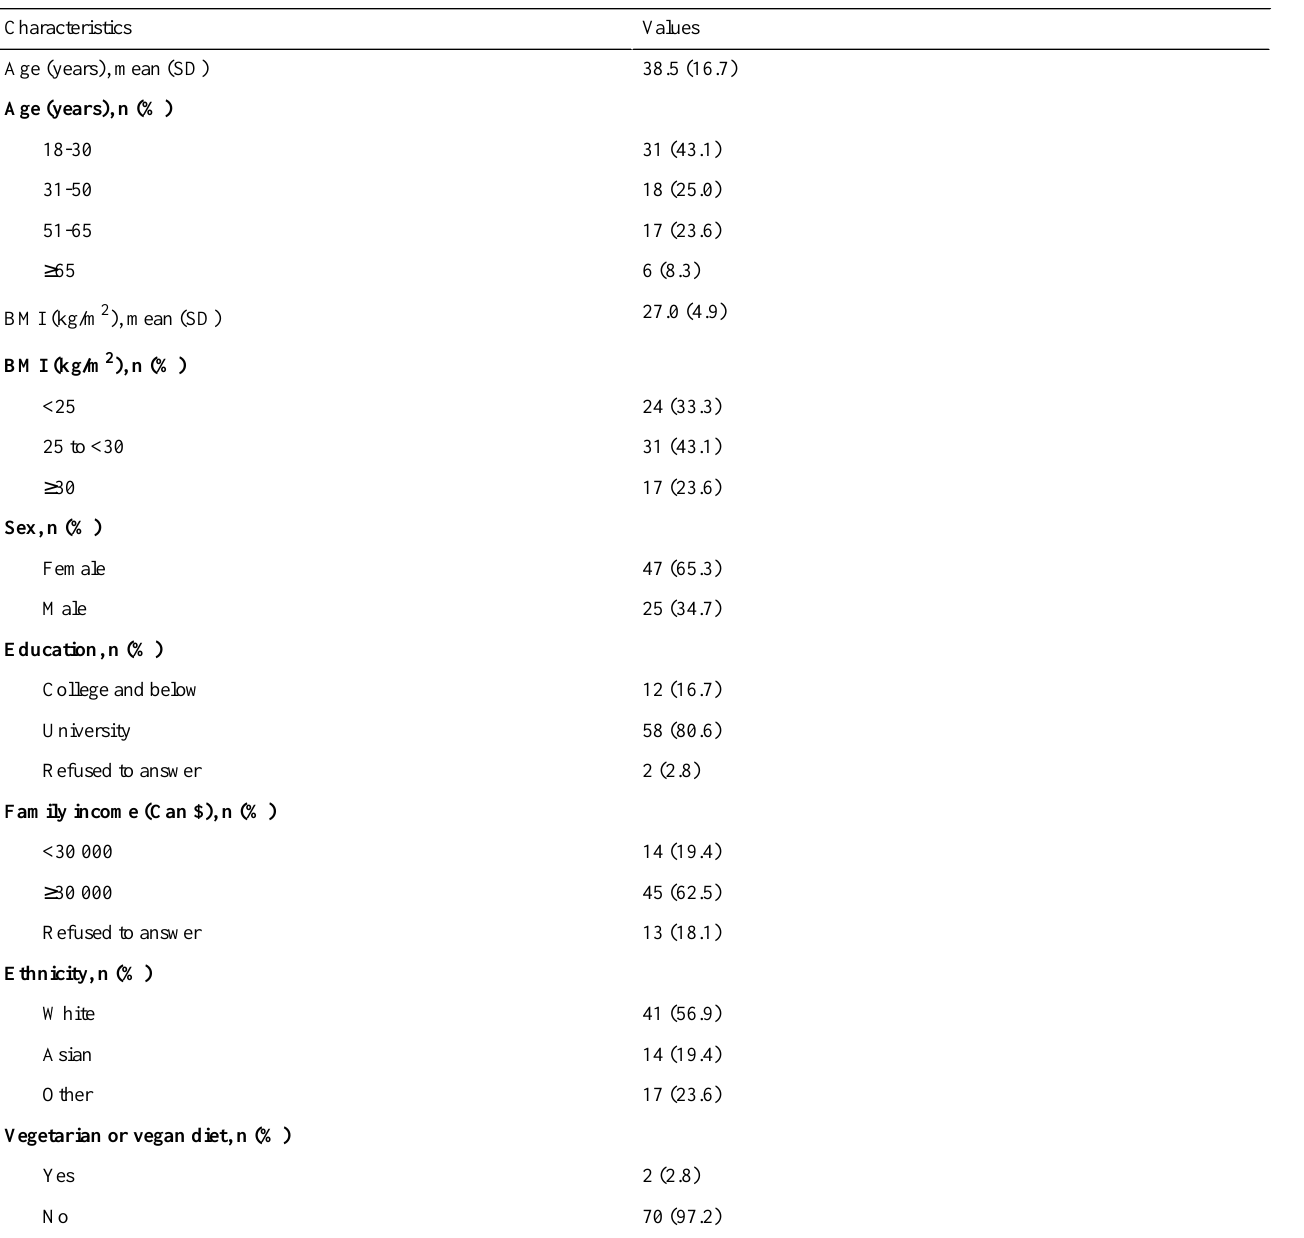
Table 1. Participant demographic characteristics